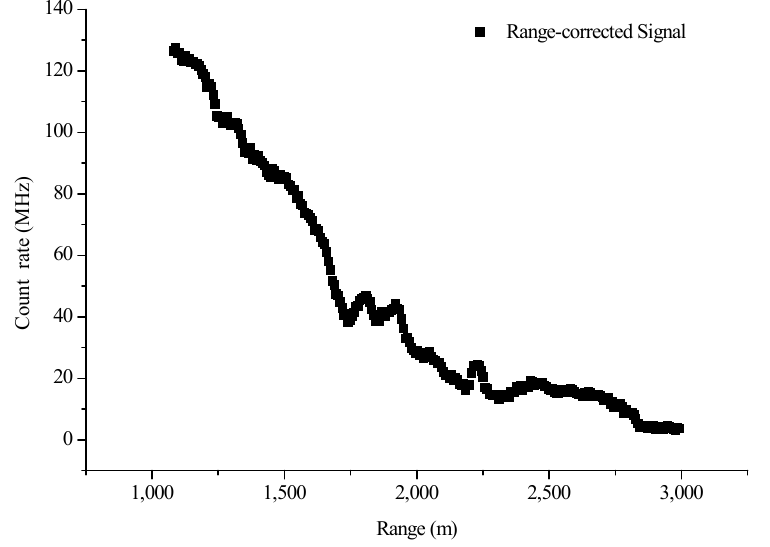
Figure 14. Range ‐ corrected signal at an altitude range of 1000–3000 m (30 July 2016). Figure 14. Range-corrected signal at an altitude range of 1000–3000 m (30 July